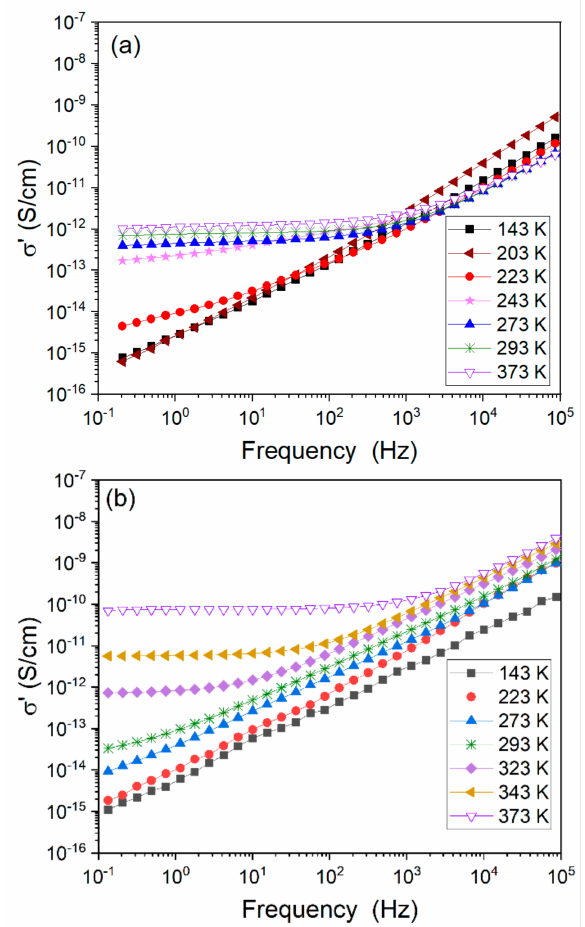
Figure 5. Representation of the real part of conductivity ( σ ’) at selected temperatures for ( a ) neat PDMS and ( b ) bpyPDMS-ZnCl 2 as a function of